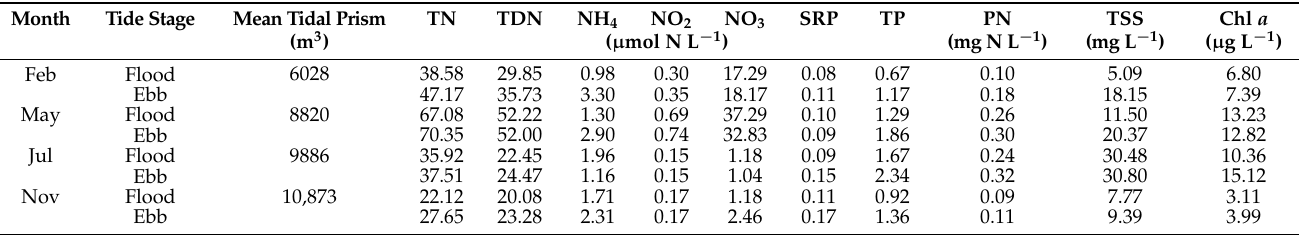
Table A1. Volume-weighted water column concentrations of all measured constituents during four seasonal tidal flux deployments in